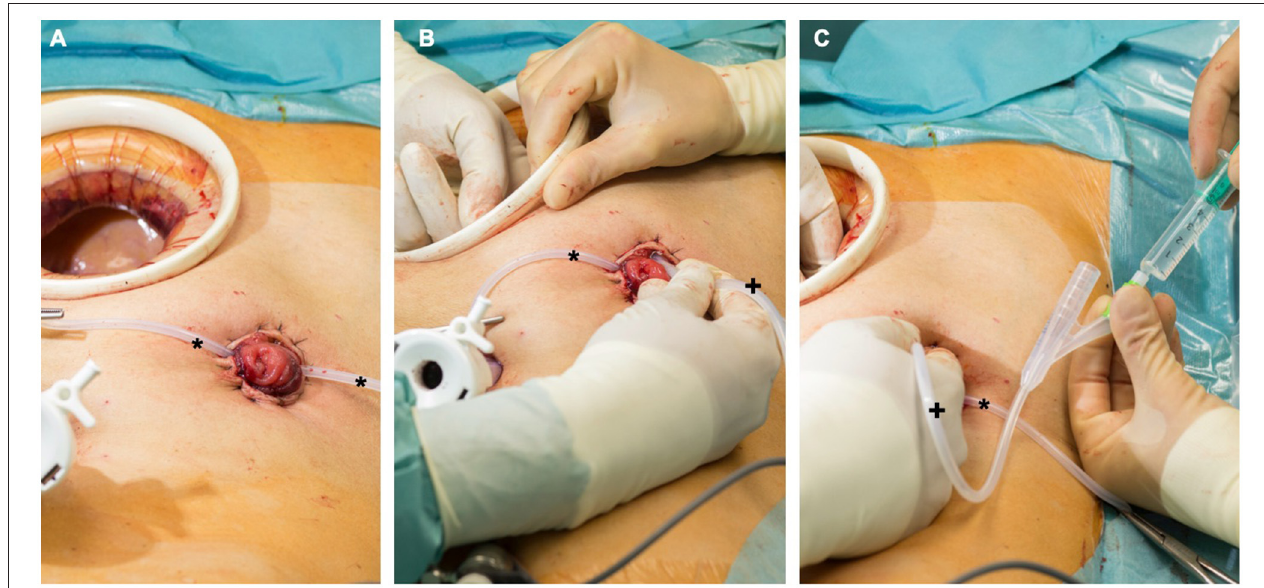
FIGURE 2 | (A) Protective ileostomy after rectal resection. The Pfannenstiel incision is still protected by a wound retractor. A loop (*) is stabilizing the stoma during manipulation. (B) A urinary catheter ( + ) is placed in the efferent loop. (C) The catheter ( + ) is blocked under manual control with 5ml before starting the antegrade colonic irrigation. The intestine can be checked within the procedure by one surgeon to prevent dislocation of the catheter or accidental perforation.